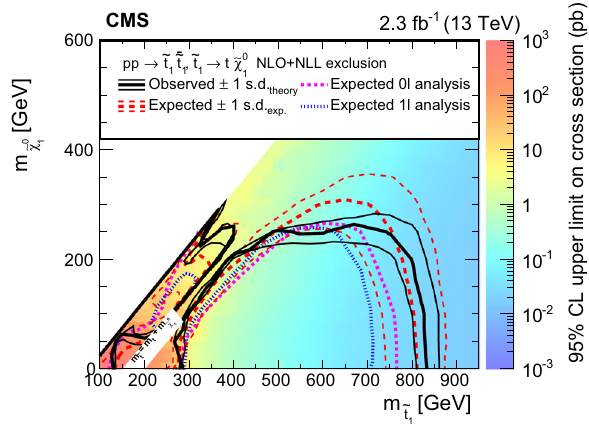
Fig. 7 Exclusionlimitsat95%CLfordirecttopsquarkpairproduction . The interpretation is performed in the for the decay mode (cid:2) t 1 → t ( ∗ ) (cid:2) χ 0 1 two-dimensional space of m (cid:2) t vs. m (cid:2) χ 0 . The color indicates the 95% 1 1 CL upper limit on the product of cross section and branching fraction at each point in the m (cid:2) t - m (cid:2) χ 0 plane. The regions enclosed by the thick 1 1 black curves represent the observed exclusion at 95% CL, while the dashedredlines indicatetheexpectedlimitsat95%CLandtheir ± 1SD experimental uncertainties. The thin black lines show the impact of the ± 1SDtheoreticaluncertaintiesinthesignalcrosssection.The magenta short-dashed curve and the blue dotted curve show the expected limits for the analysis in the all-jet (Sect. 4) and single-lepton (Sect. 5) final states, respectively. The limits in the region near (cid:4) m ≈ m t and low (cid:2) χ 0 1 mass are not shown due to the difficulty in modelling rapidly varying kinematics in this